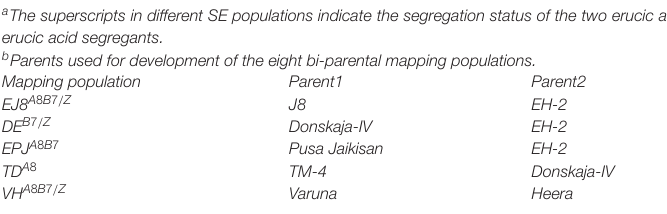
content trait are given in Table 1 . These parental lines covered maximum phenotypic variability reported for the two traits in